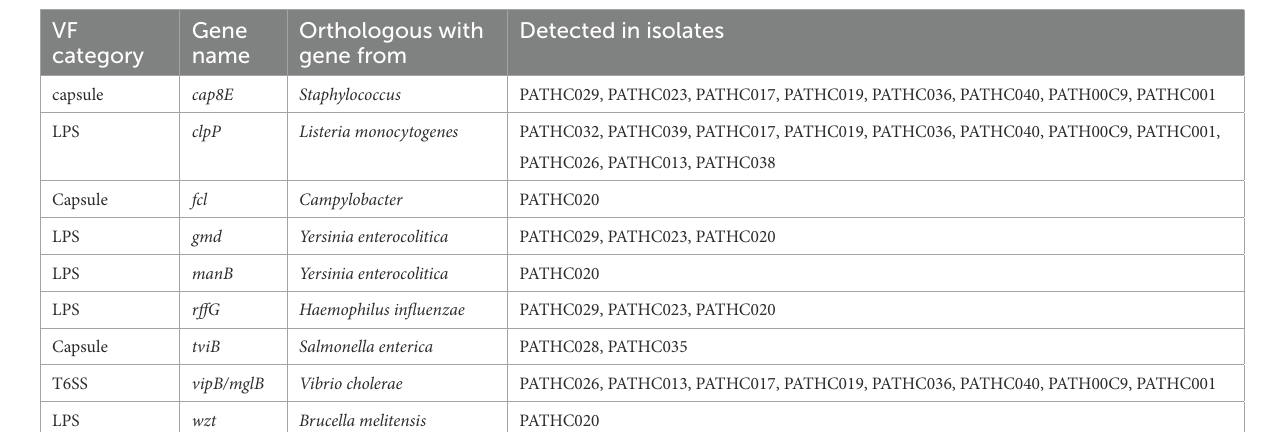
TABLE 4 Virulence factors (VF) found in exclusively non-pneumophila